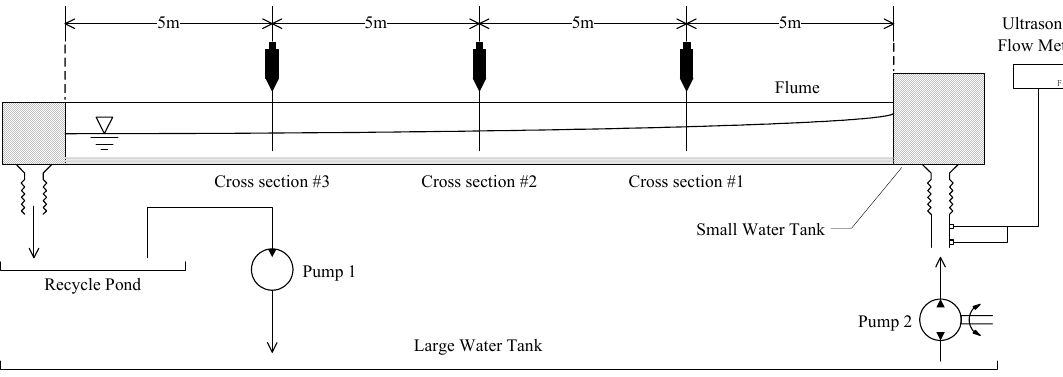
Figure 1. Experiment flume with its recirculation system.